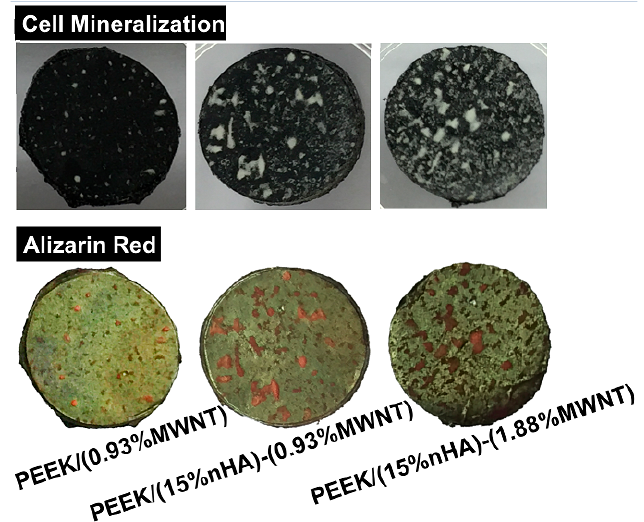
Figure 15. Representative photographs showing calcium mineralization (before staining) on PEEK/(0.93% MWNT), PEEK/(15% nHA)-(0.93% MWNT) and PEEK/(15% nHA)-(1.88% MWNT) nanocomposites cultured with murine MC3T3-E1 pre-osteoblasts for 28 days ( top ); Calcified nodules appeared as a dark red color on these samples after staining with Alizarin red-S ( bottom ).